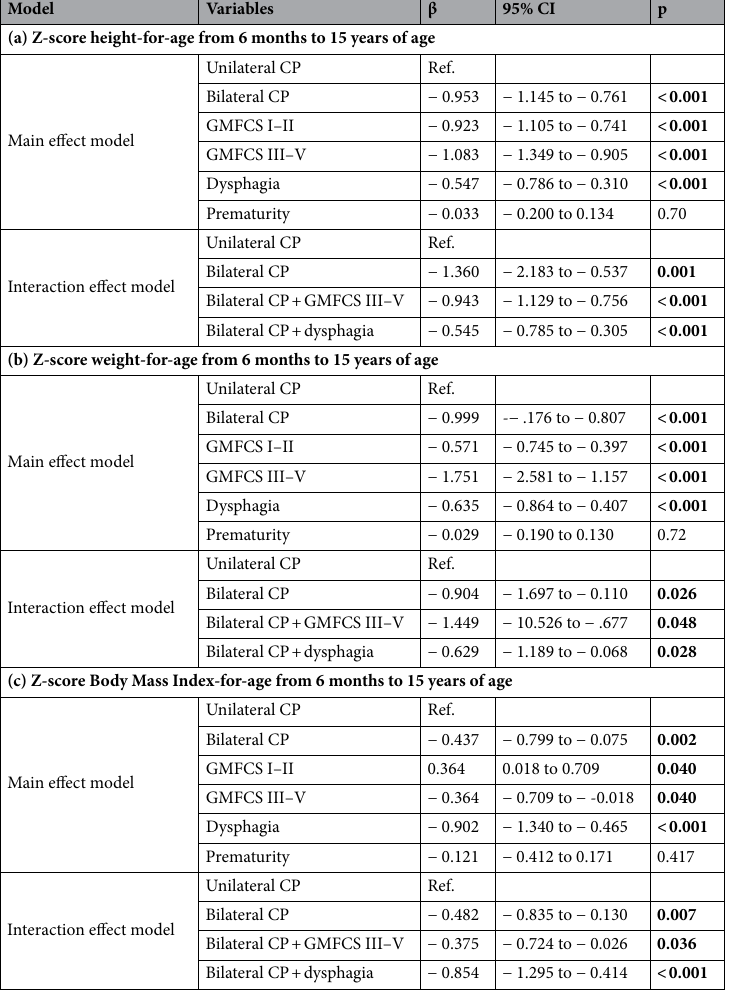
Table 2. Mean z-score change for height and weight in children with unilateral and bilateral cerebral palsy (linear mixed models) (n = 1536). Significant differences are marked in bold letters. GMFCS Gross Motor Function Classification